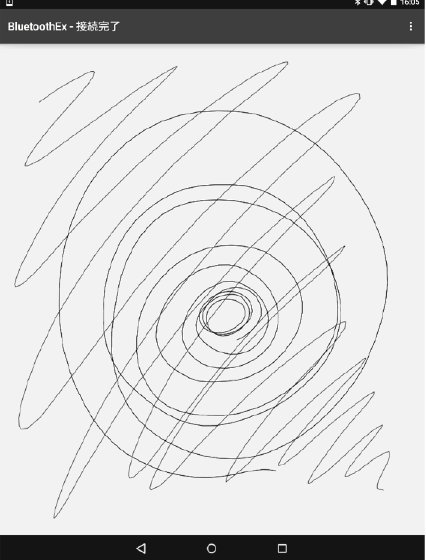
Fig. 3 Environment for survey on influence of hand